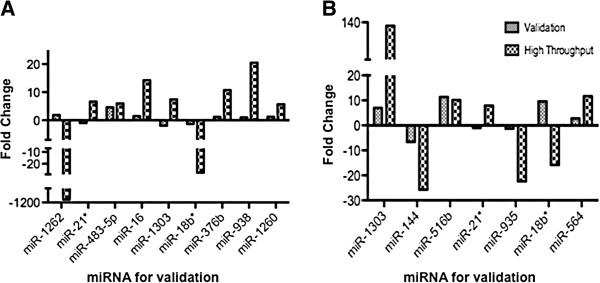
Independent individual validations of randomly selected differentially regulated miRNAs from Taqman array platform. qRT-PCR was used to validate the expression of selected miRNAs from the high throughput results (derived by StatMiner) using a specific primer and probe for each miRNA. (A) miRNAs selected from Control versus LVL comparison; (B) miRNAs selected from control versus HVL comparison. Fold increase/decrease was calculated based on normalization to U6. Average fold change for each miRNA represents fold change obtained from independent donors (N = 5 per group).